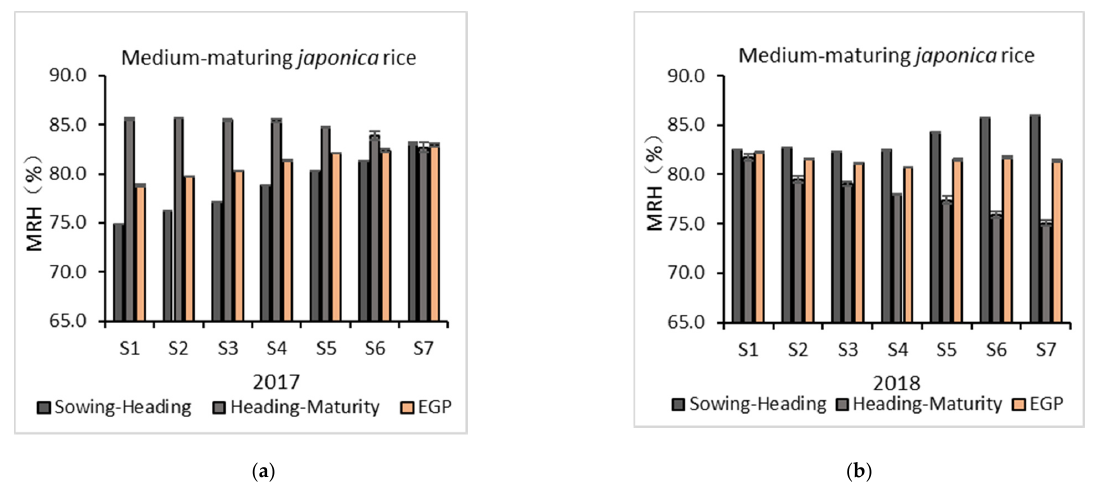
Figure 6. Difference of mean relative humidity (MRH) of medium-maturing japonica rice under different sowing dates: ( a ) 2017; ( b ) 2018.